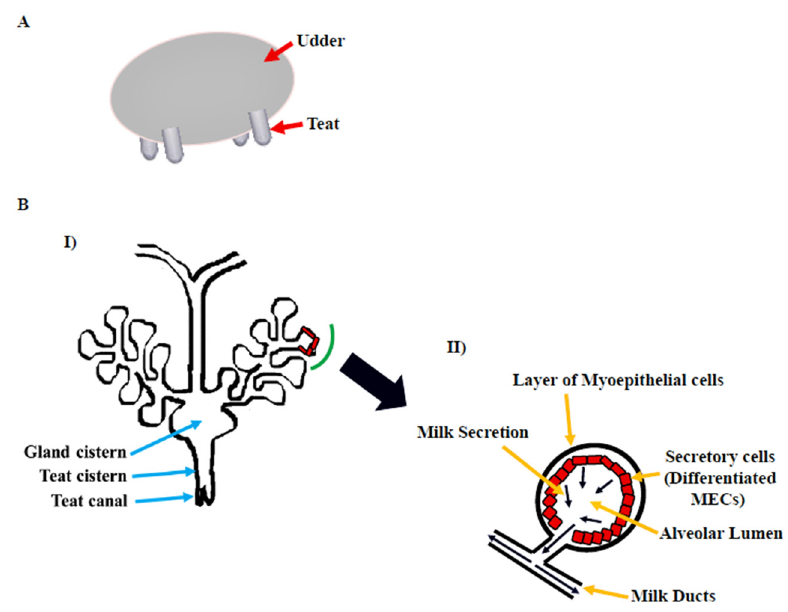
Figure 1. Bovine mammary gland. ( A ) Diagram illustrating the bovine udder. ( B ) I: Microscopic anatomy of bovine mammary gland consisting of milk ducts, alveoli, cistern (gland and teat), and teat canal. II: Secretory unit of mammary gland, i.e., alveolus containing milk-secreting mammary epithelial cells (MECs), covered by the myoepithelial cells which are in direct contact with extracellular matrix (ECM) [6].